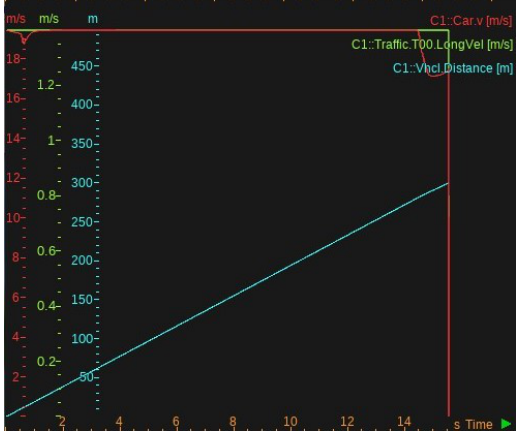
Figure 15. The collision happens at a distance of 300 m from the